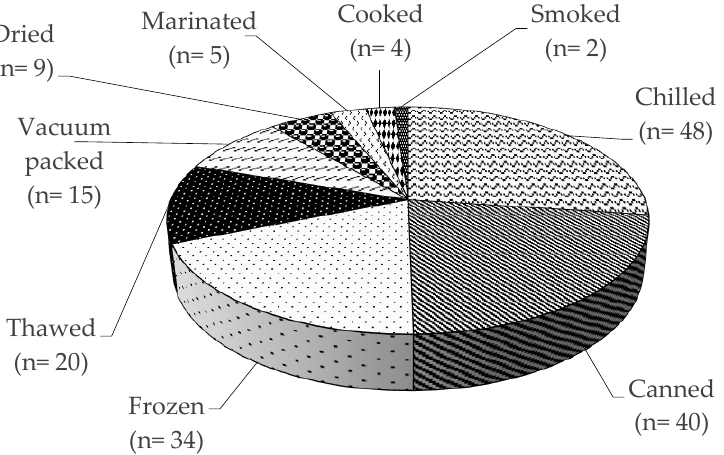
Figure 4. Presence of histamine in different fish products according to the Rapid Alert System for Food and Feed (RASFF) from 1 January 2015 to 31 August 2020. Table 5. Histamine concentrations reported in “fish and fish products” by the Rapid Alert System for Food and Feed (RASFF) from 1 January 2015 to 31 August 2020.